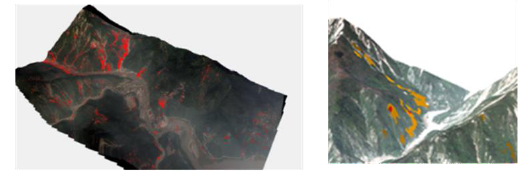
Figure 4. object oriented image interpretation toolbox based on transfer learning and deep neural network